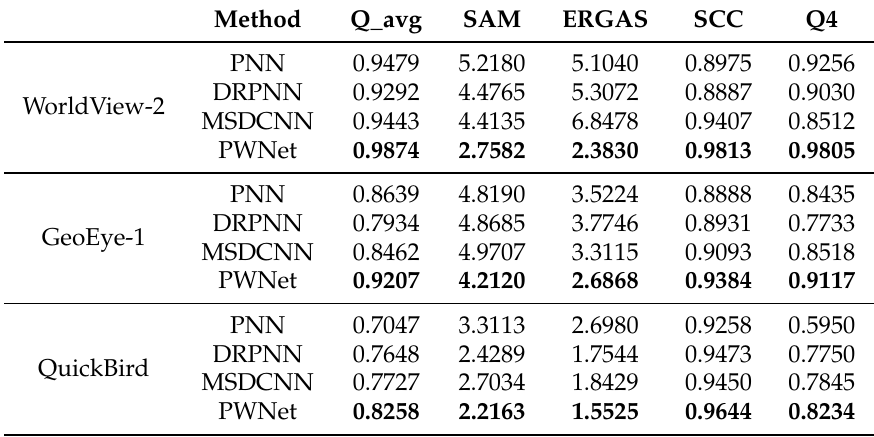
Table 8. Quantitative comparison of the CNN-based methods on three test data sets. The best results are highlighted in